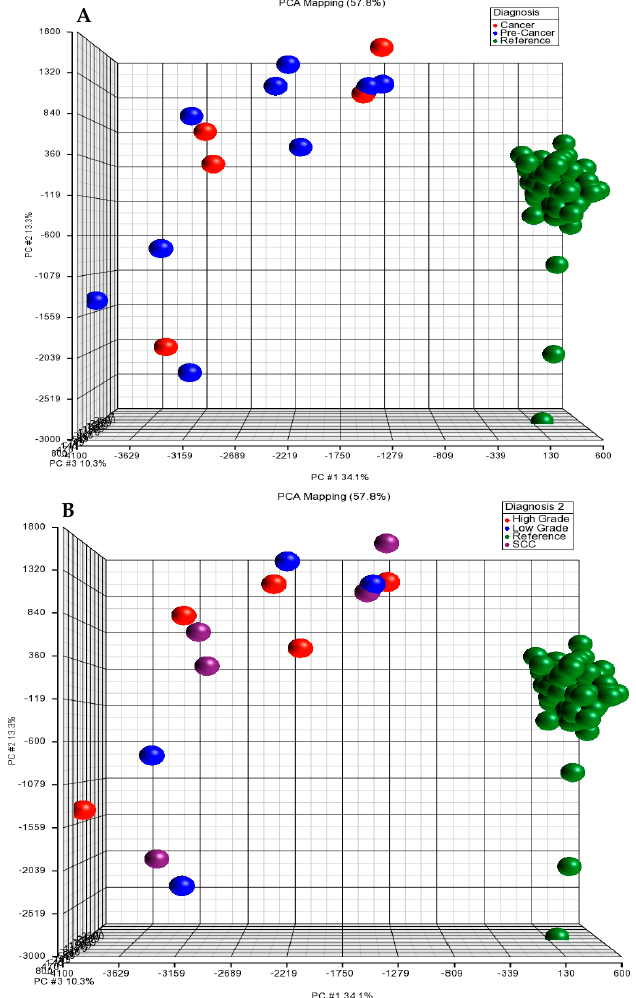
Figure 2. Plot of principal component analysis (PCA) and hierarchical clustering of copy number variation (CNV) or CNA datasets. ( A ) PCA scatter plot of three diagnostic groups (pre-cancer, cancer and reference). Each point represents a specific sample. Points are colored by group status, with blue representing pre-cancer (CIN-I, -II and -III), red representing invasive cancer and green representing references. ( B ) PCA scatter plot of four diagnostic groups. Each point represents a specific sample. Points are colored by group status, with blue representing low grade (CIN-I), red representing high grade (CIN- II and -III), purple representing invasive cancer and green representing